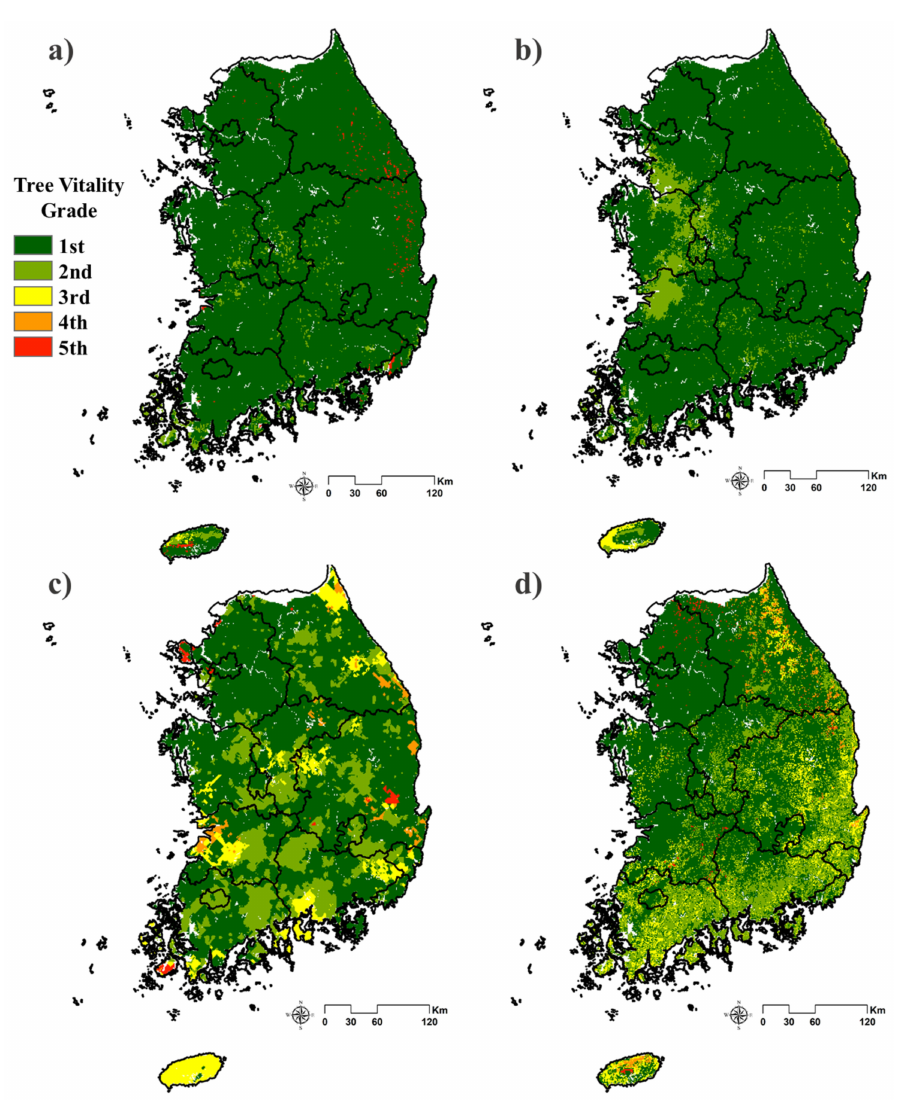
Figure 4. Tree vitality maps created using: ( a ) Multinomial logistic regression (MLR); ( b ) random